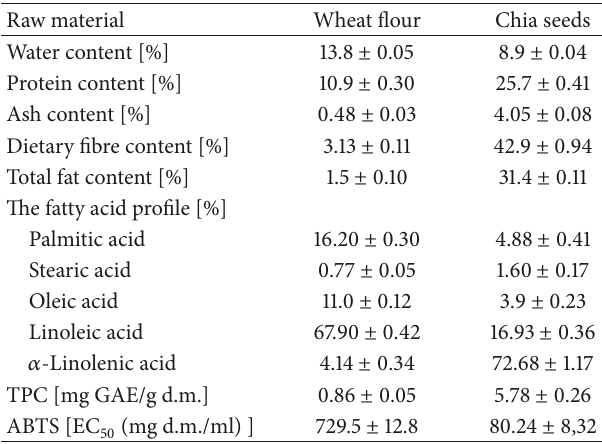
Table 2: Chemical composition, fatty acids profile, total phenolics content (TPC), and antioxidant activity (ABTS) of raw